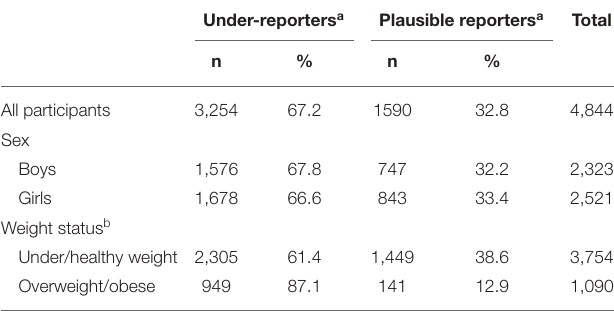
TABLE 1 | Differences by sex and weight status in 13-year-old adolescents grouped by their accuracy of reporting of energy intake in food